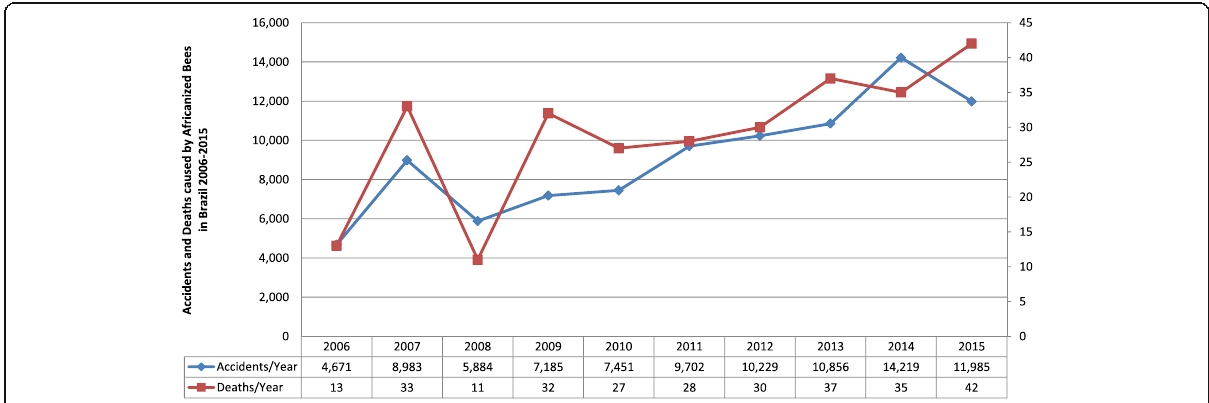
Fig. 1 Temporal distribution of the number of cases reported for Africanized honeybee sting in Brazil between 2000 and 2015